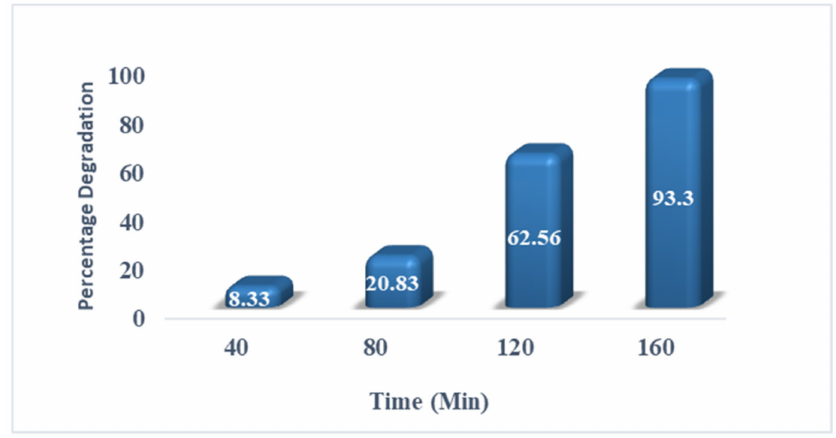
Figure 10. Graphical representation of percentage dye degradation.